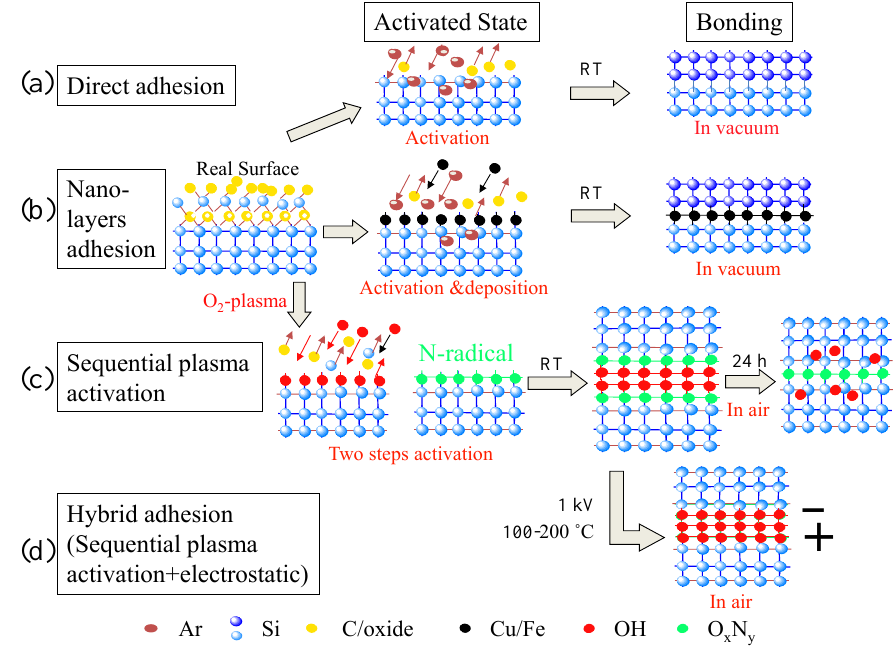
Figure 10. Schematic for surface activated bonding (SAB) technologies that provide atomic-level bonding through: ( a ) Direct adhesion; ( b ) Nano-layers adhesion; ( c ) Sequential plasma activation; ( d ) Hybrid adhesion [16] (Reproduced with permission